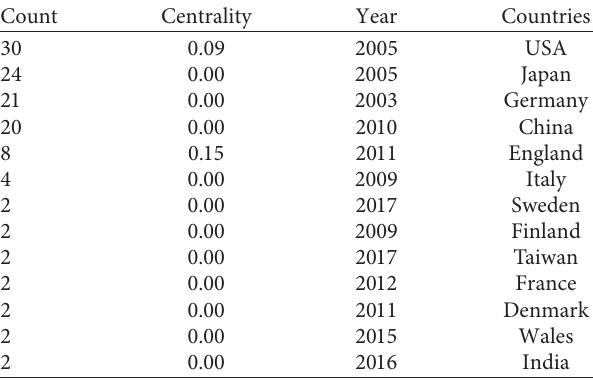
Table 3: The list of authors.